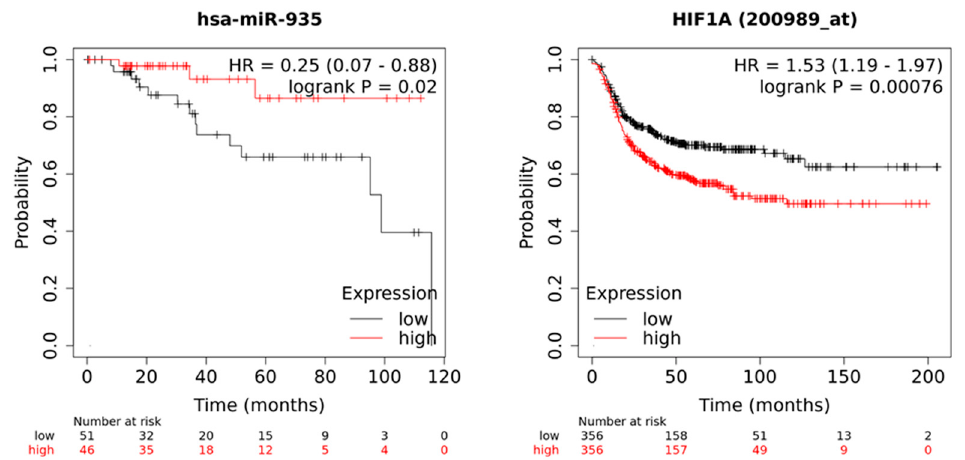
Figure 9. Kaplan–Meier curves for overall survival according to miR-935 and HIF1A expression. A cohort of triple-negative breast cancer patients with a median follow-up of 33 months was analyzed. Gene expression data and overall survival information were downloaded from TCGA. Patient prognostic values were obtained by dividing patient data into two groups according to various quantile expressions of miR-935 (miRpower tool 97 TNBC patients) and HIF1A gene (Start KM plotter, 712 TNBC patients). The two cohorts of patients were compared using a Kaplan–Meier survival plot, and the hazard ratio with 95% confidence intervals and log-rank p -value were calculated.